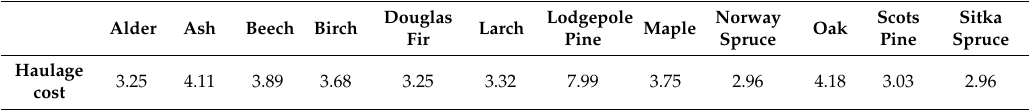
Table A4. Haulage cost (in € m − 3 ) used in the model, based on species assortment and transport distance to suitable processing mills.